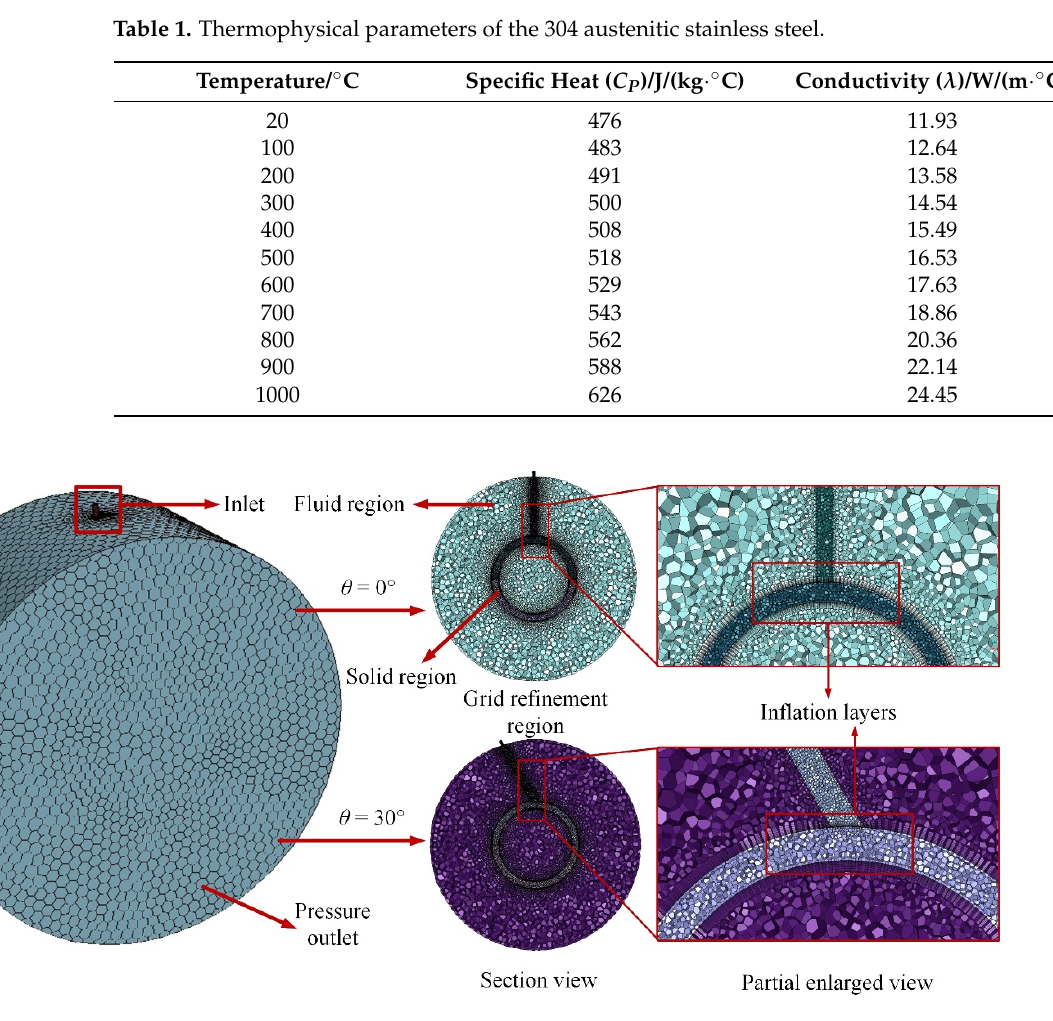
Figure 2. The mesh diagram of inclined jet impacting steel tube.